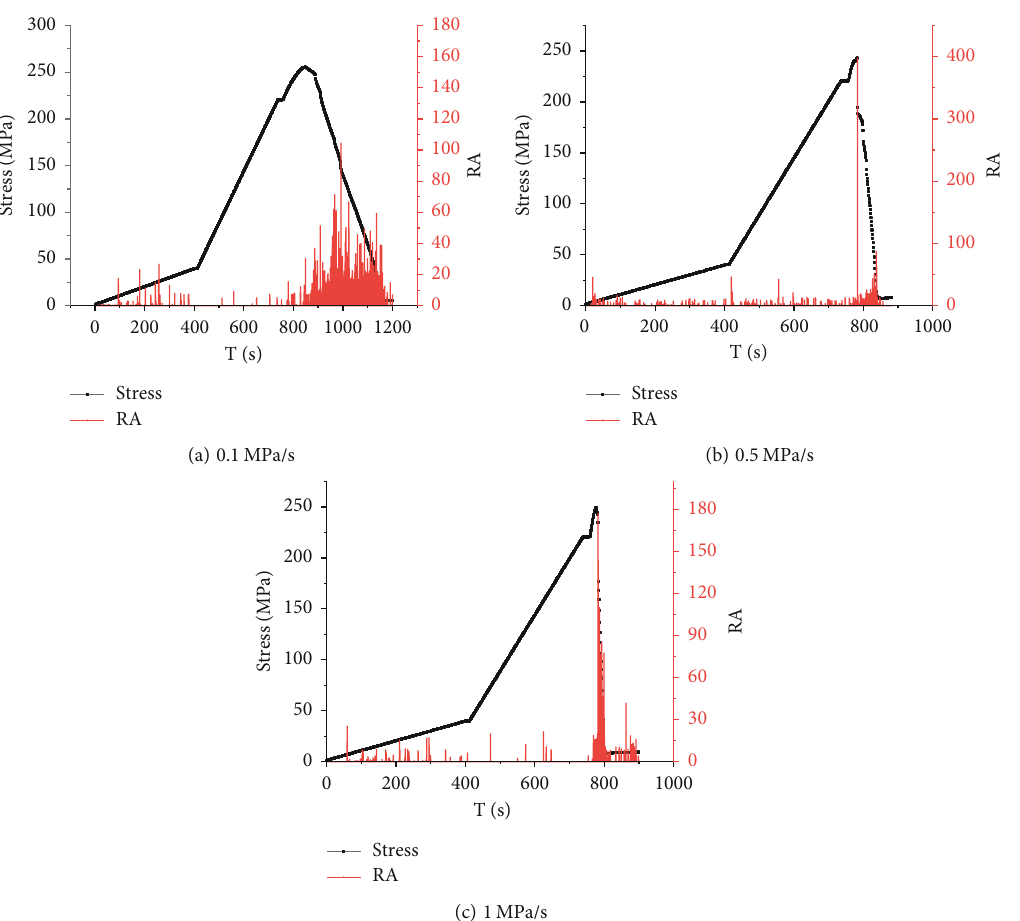
Figure 5: Limestone time-stress-entropy relationship curve under the same con fi ning pressure (40 MPa) and di ff erent unloading